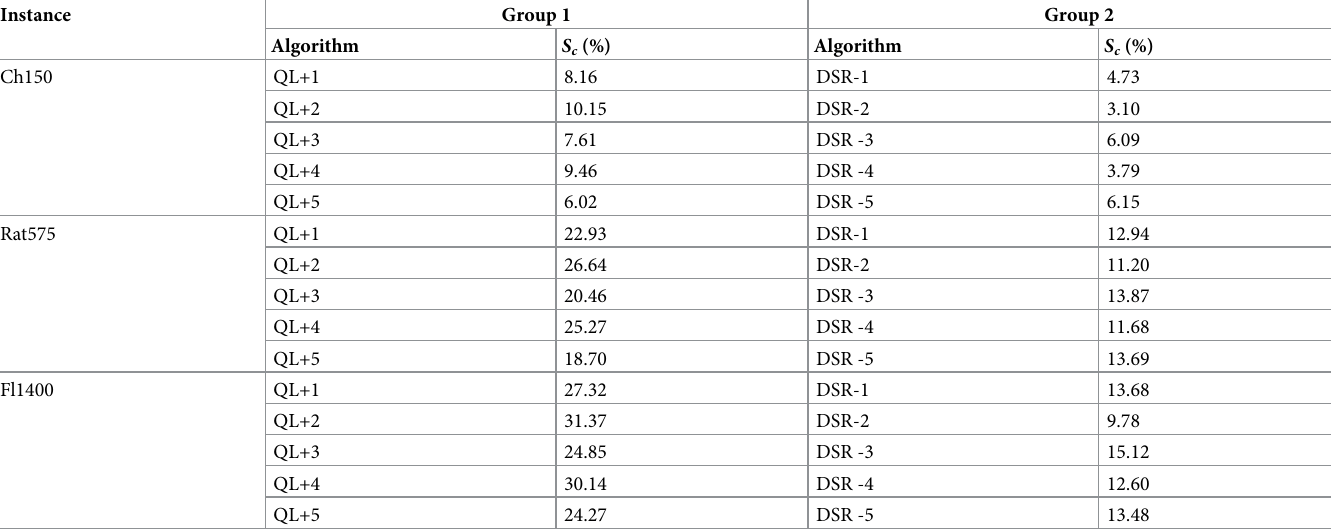
Table 7. S c of ch150, rat575 and fl1400 for algorithms of each group.